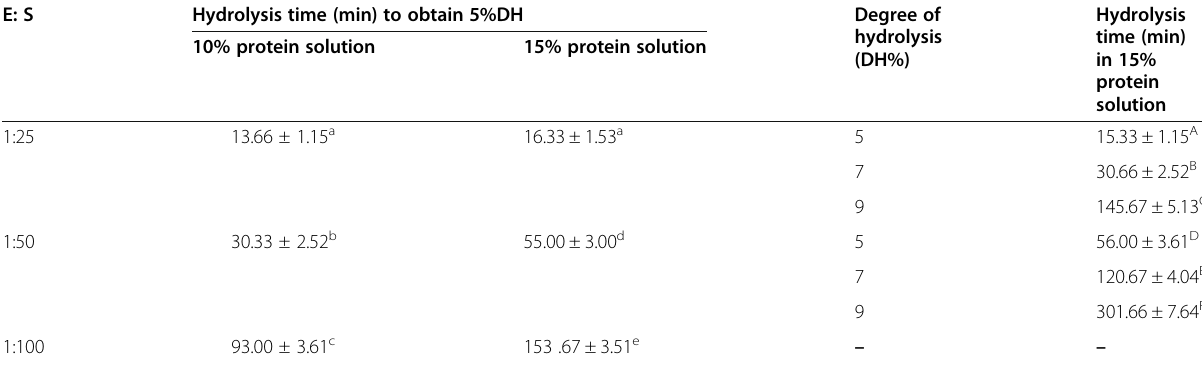
Table 2 Effect of E/S ratio and protein concentrations on the time to obtain DH of 5% and the effect of E/S ratio and DH on hydrolysis time in 15% protein